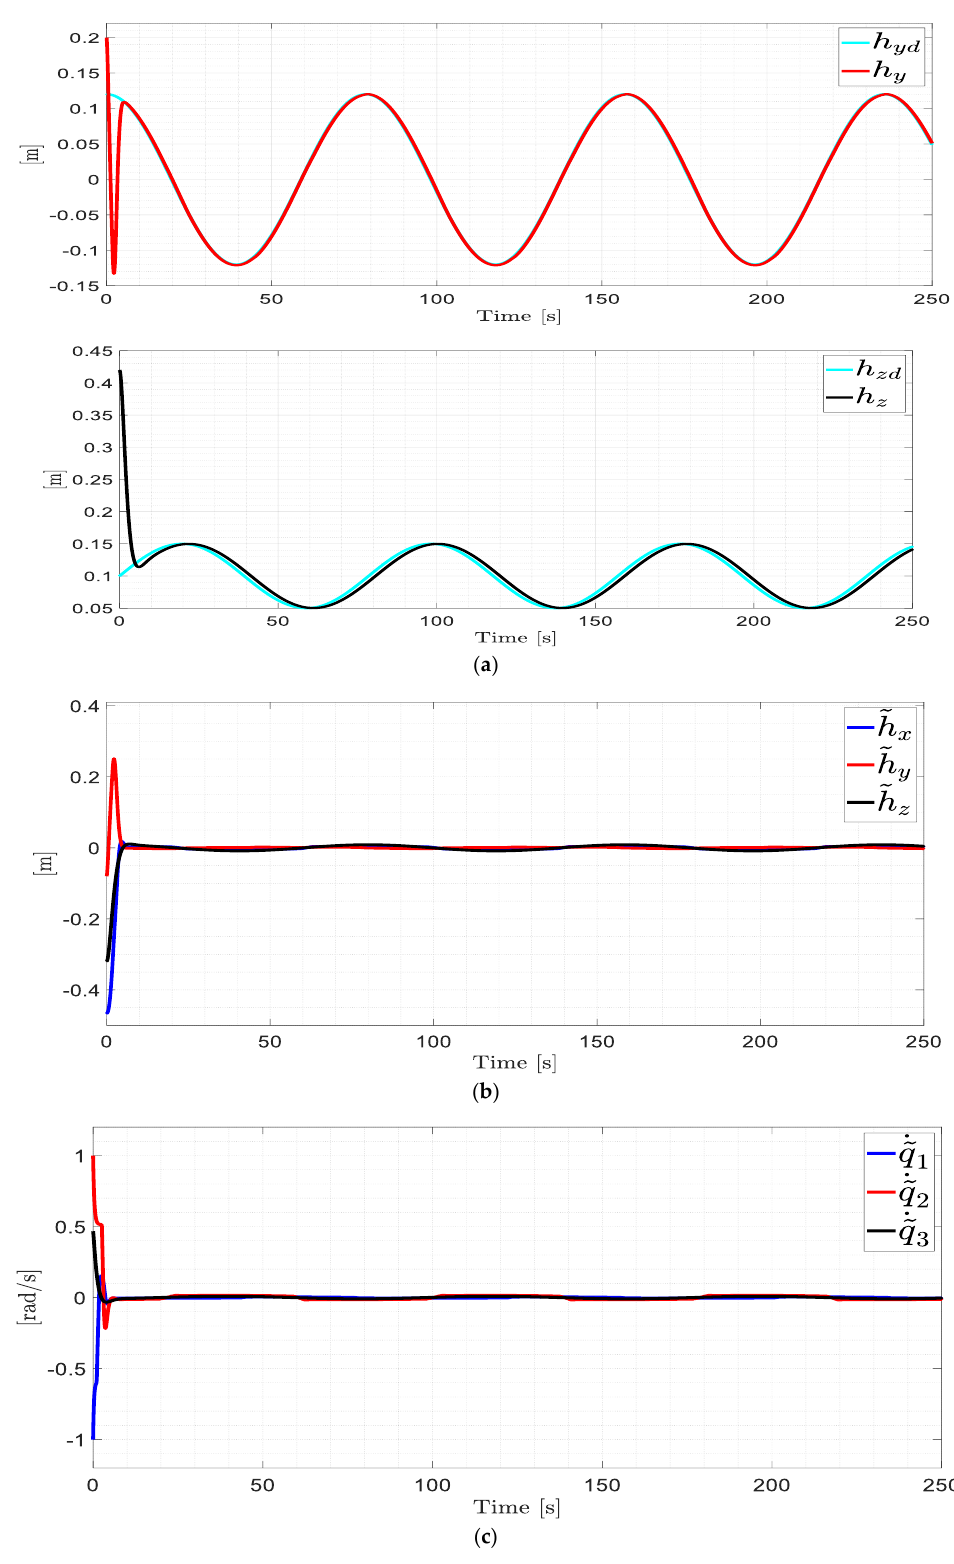
Figure 10. Movements of the Scara robot while executing a trajectory task in the laboratory environ- ment using the Full simulation technique. ( a ) Desired trajectory and actual trajectory executed by the SCARA robot. ( b ) Robot operating end control errors. ( c ) Velocity control errors.